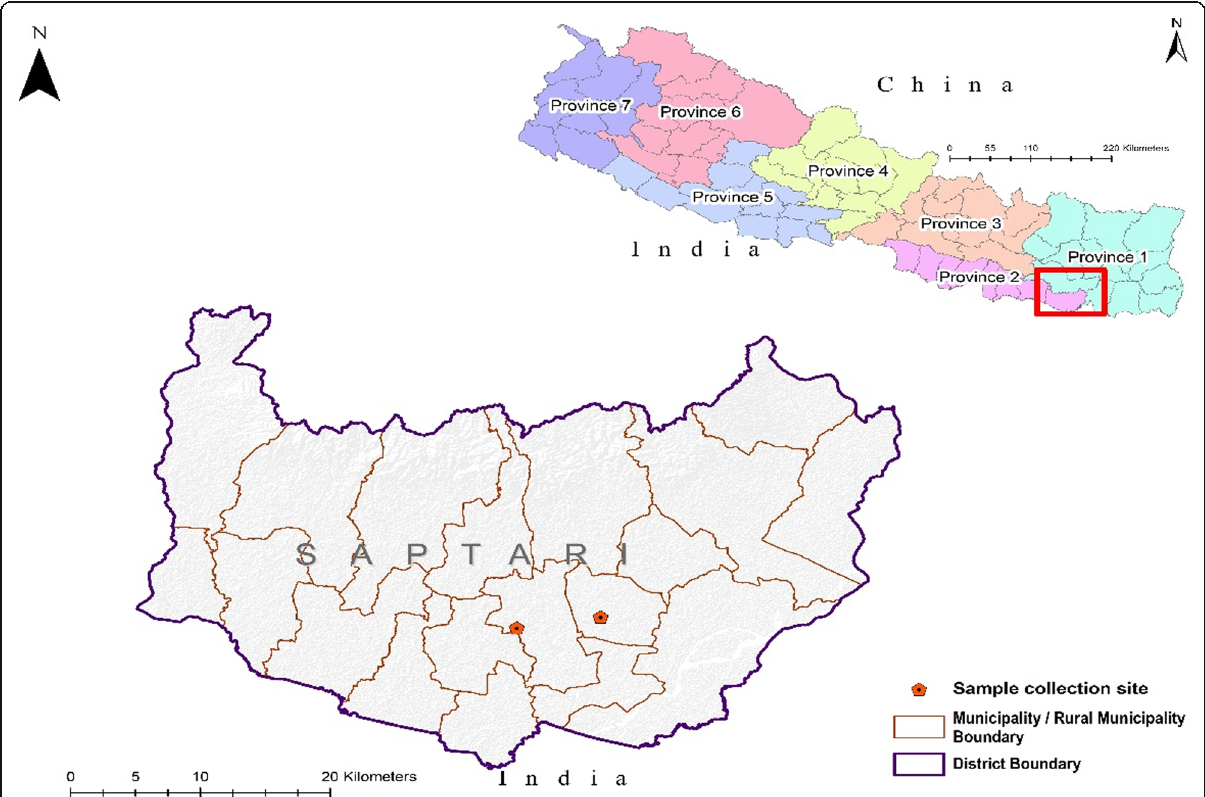
Fig. 1 GIS map showing the geographic location of Saptari district,